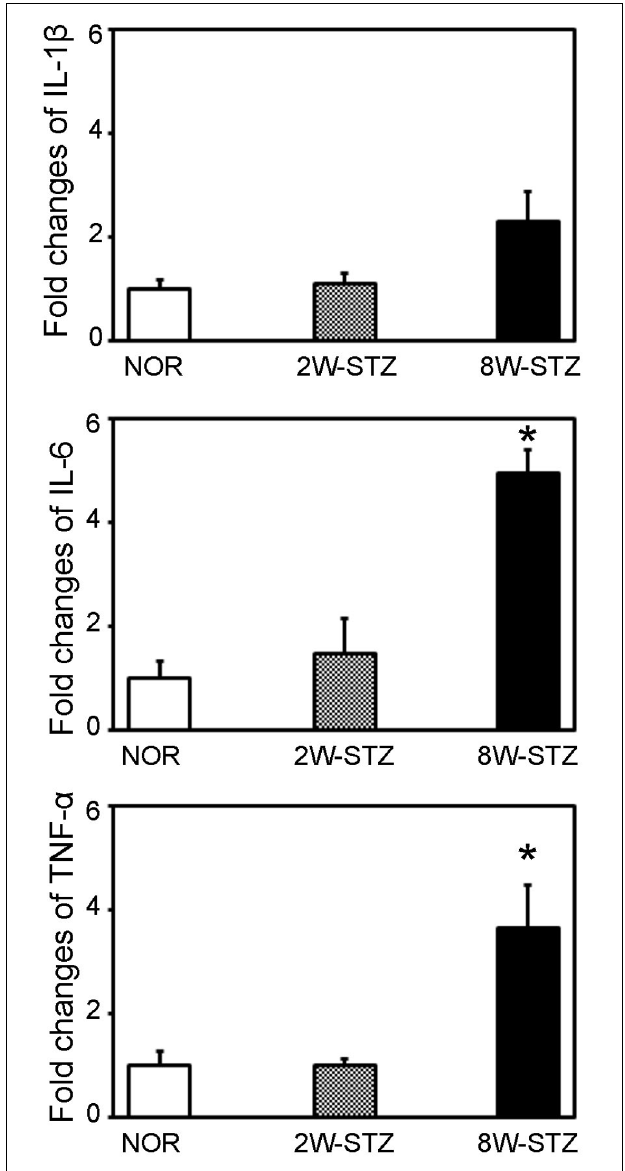
FIGURE 7 | The mRNA level of inflammatory cytokines in the diabetic and normal rats. Bar graph showed the quantification of TNF- α , IL-1 β and IL-6 mRNA level in the normal, 2- and 8-week STZ rats. Data were normalized to the internal control. Data are mean ± SD, n = 4 per group. ∗ p < 0.05, 8W-STZ vs. normal rats. NOR, normal rats; 2W-STZ, 2-week STZ; 8W-STZ, 8-week